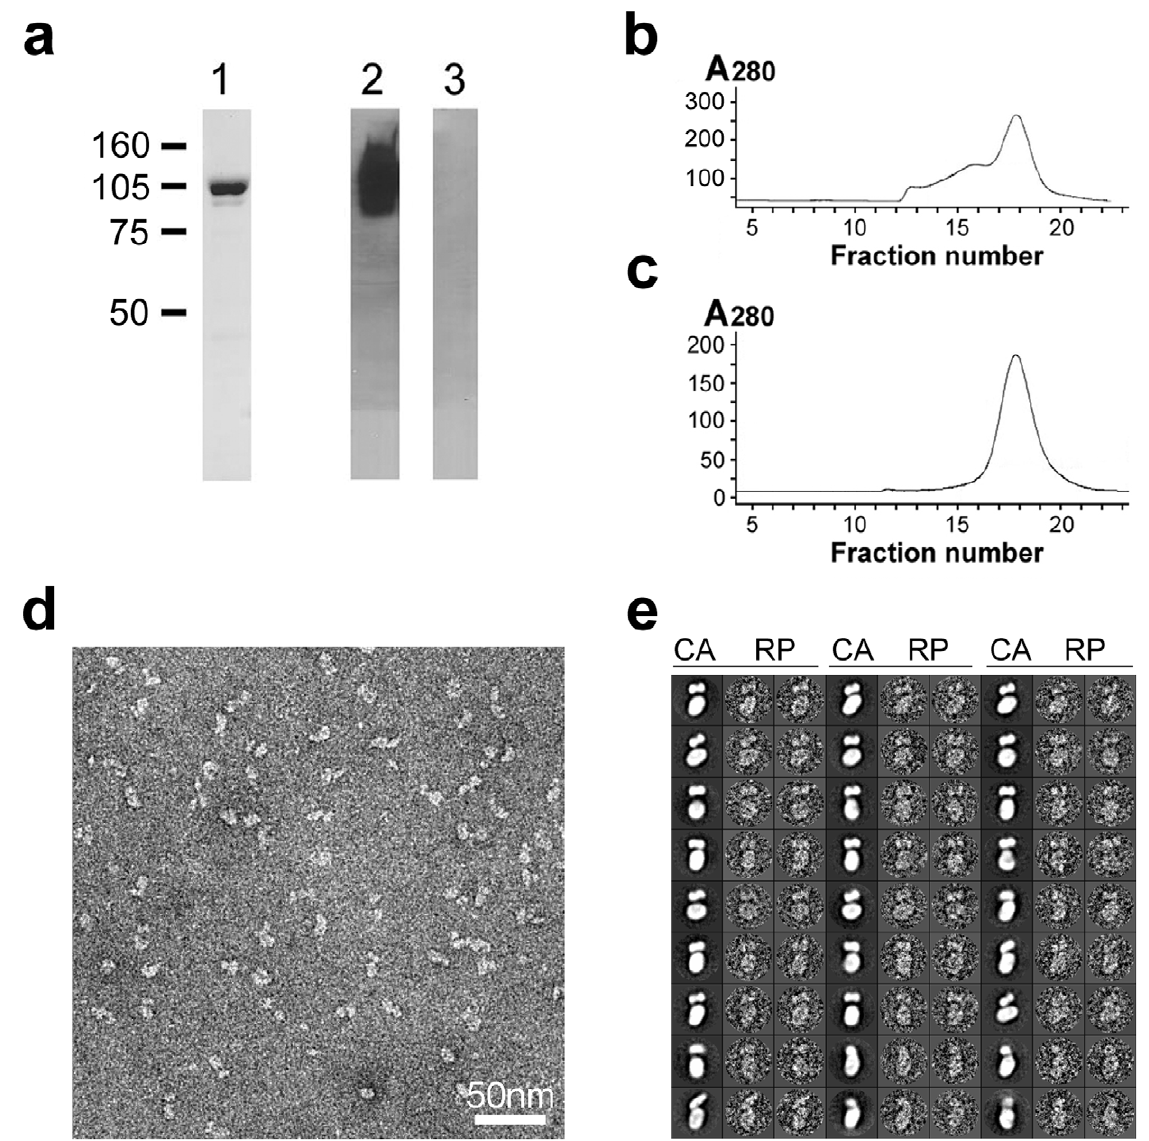
Figure 1. Purification and EM of bovine AE1. ( a ) SDS-PAGE of bovine AE1 after ion-exchange chromatography. Lane 1: Coomassie stained gel; Lanes 2,3: immunoblotting, 2: immune serum; 3: preimmune serum. ( b,c ) Size-exclusion chromatography examination of bovine AE1 sample after the ion-exchange chromatography step (top) and the dimer fraction after the size-exclusion chromatography step ( c ) showing a peak corresponding to dimeric AE1. ( d ) A representative area of transmission EM micrograph of bovine dimeric AE1 stained with 1% uranyl formate. ( e ) Representative class averages (CA) and the corresponding raw particle (RP) images of AE1. Each class average is obtained by averaging about 100 particle images. The side length of each box is 26